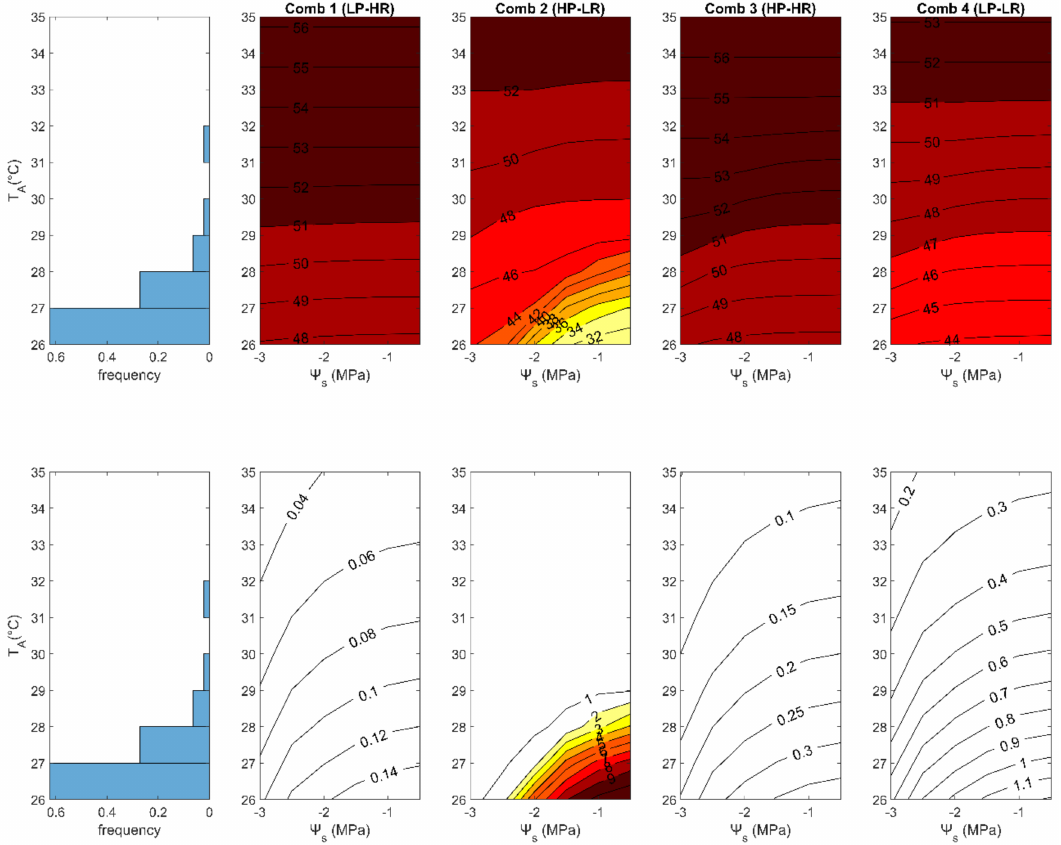
Figure 4. Leaf temperatures (top row; in ◦ C) and net assimilation rates (bottom row; in µ mol m –2 s –1 ) for di ff erent air temperatures and soil water potentials. The baseline temperature corresponds to the warmest day of the growing season 2005. All the other parameters are as in Figure